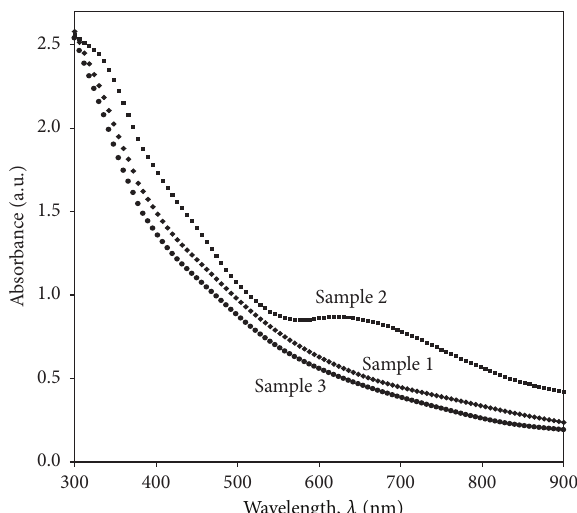
Figure 3: The absorbance versus wavelength for three samples with different additives.